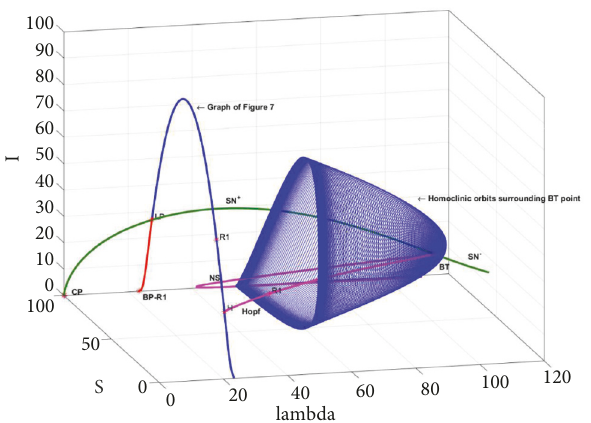
Figure 13: Bifurcation diagram in the (𝛽,𝜆,𝐼) space showing the homoclinic orbits that emerge from the Bogdanov-Takens point.